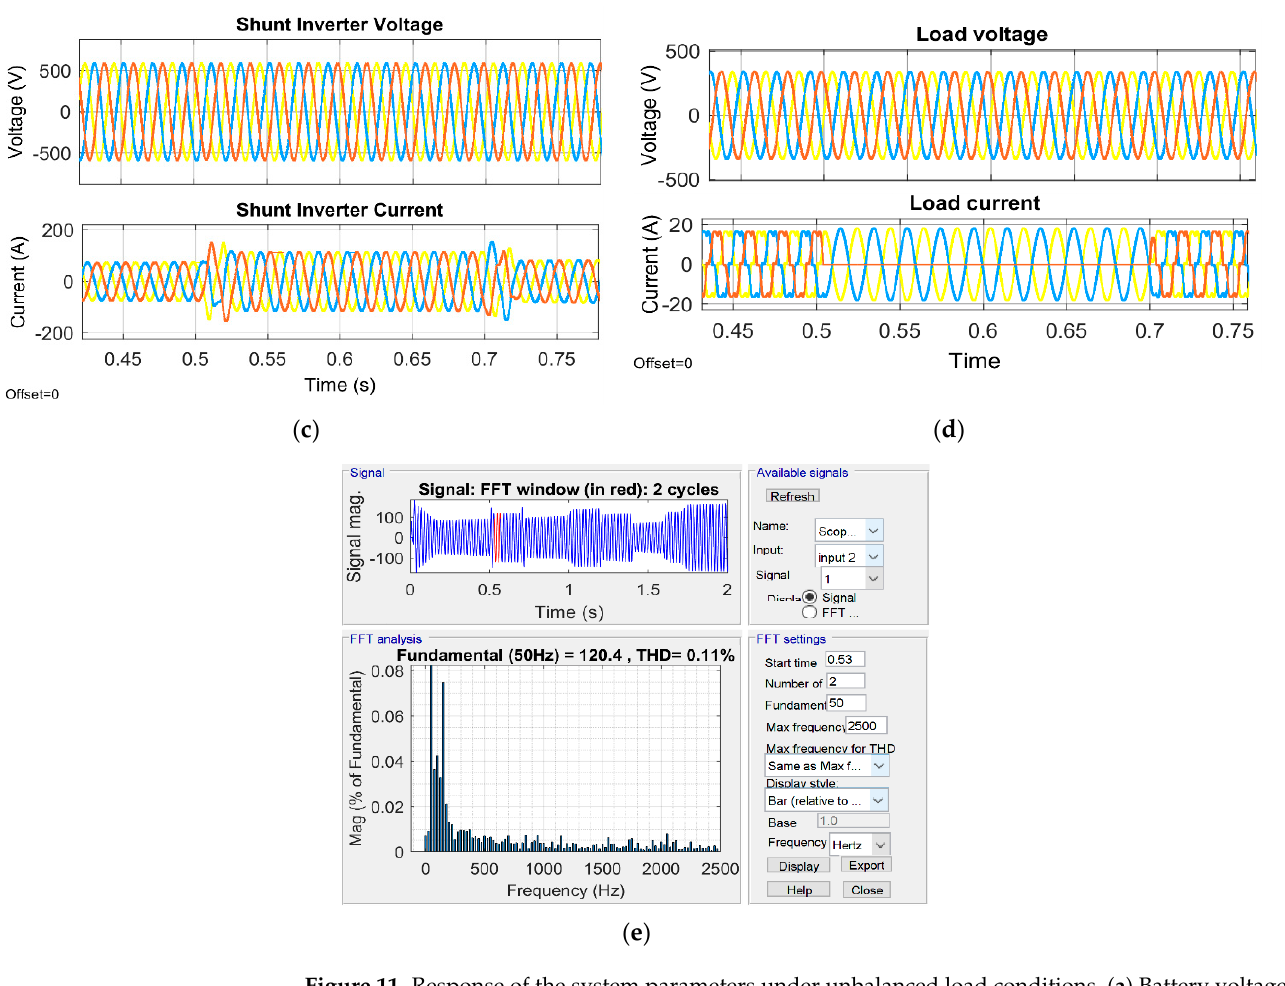
( d ) Figure 10. Response of the system parameters under non-linear load conditions. ( a ) Battery voltage and current under non-linear load condition, ( b ) Grid voltage and current under non-linear load condition, ( c ) Load voltage and current under non-linear load condition, and ( d ) THD under non- linear load condition.